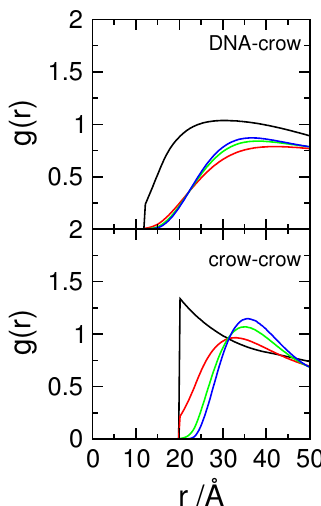
Figure 2. Radial distribution functions, g ( r ) of DNA segments-crowding agents and crowding agents-crowding agents for systems with crowding agents possessing surface charge densities, σ crow , of 0 (black), − 0.4 (red), − 0.8 (green), and − 1.2 (blue) e /nm 2 ( Φ crow =